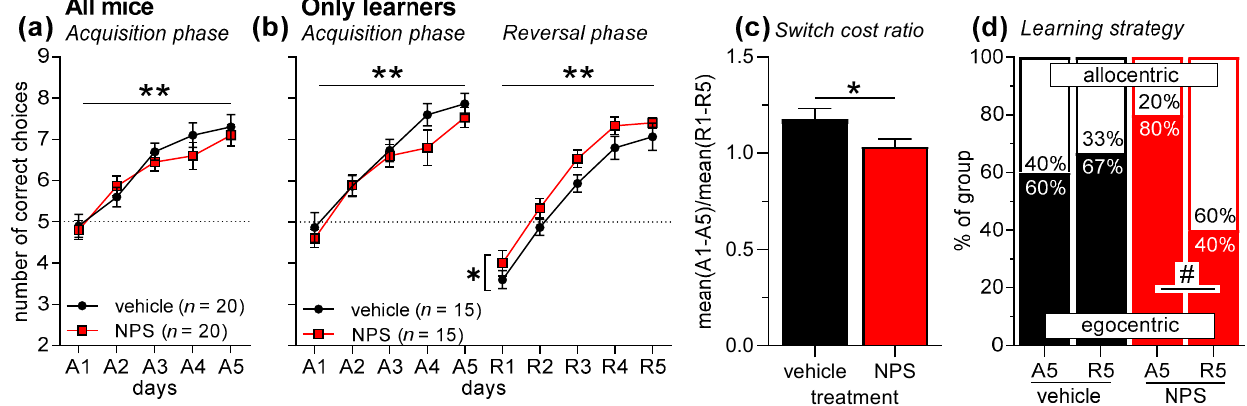
Figure 2. T-maze discrimination and reversal learning in male C57BL/6J mice after nasal NPS administration. ( a ) Mice learned to discriminate the two arms of the T-maze well; however, nasal NPS administration had no effects. ( b ) As before, mice that did not acquire discrimination learning during A1–A5 were excluded from the analyses of reversal learning and learning strategy. Mice that acquired discrimination learning (A1–A5) also learned the reversal task well (R1–R5). It is notable that nasal NPS administration improved reversal learning. ( c ) This NPS effect is confirmed by analyzing the switch cost ratio, i.e., the ratio of the mean performance during acquisition and the mean performance during reversal learning. ( d ) Vehicle-treated mice did not change their learning strategy from acquisition phase to reversal phase. However, NPS-treated mice showed a significant change from more egocentric learning in the acquisition phase to more allocentric learning in the reversal phase. ** p < 0.01, main effect of days; * p < 0.05, main effect of treatment (ANOVA or t-test, respectively); # p < 0.05 (chi-square test).